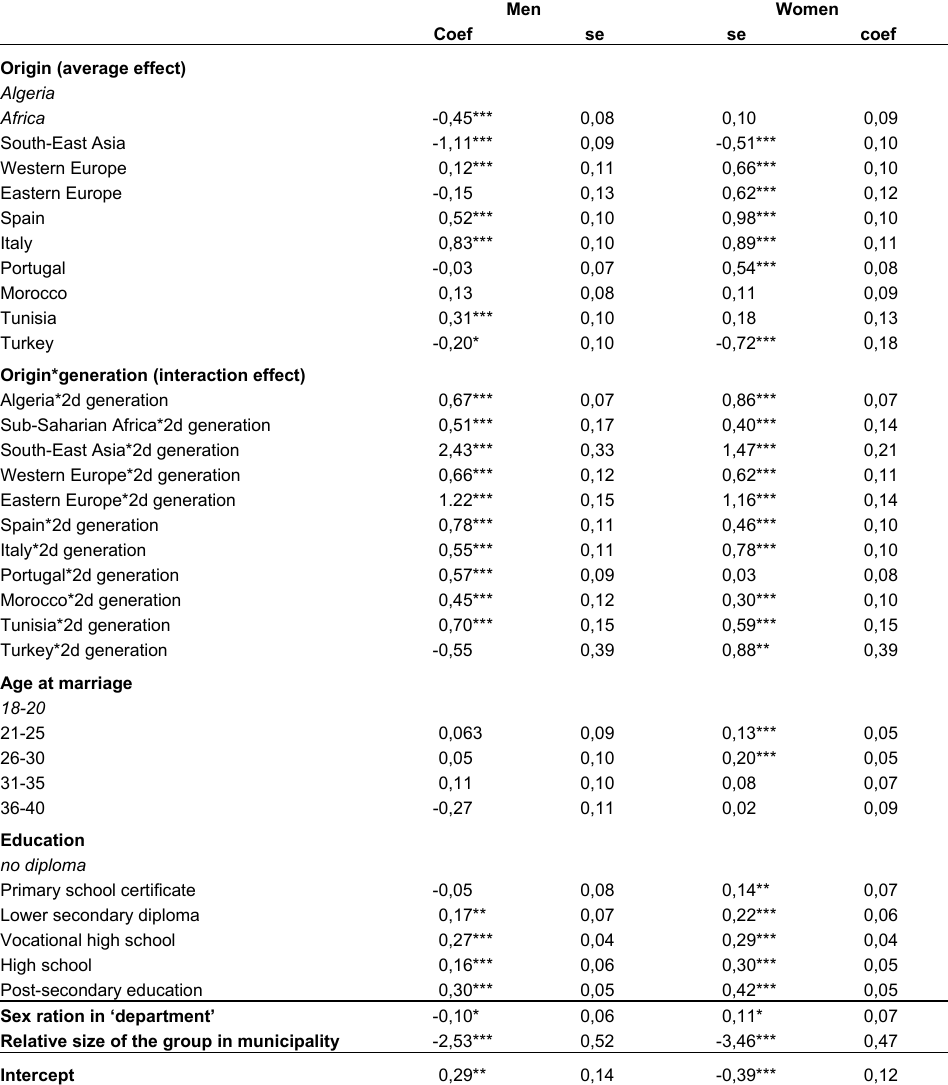
Table A.2: Probability of marriage with a French spouse born in France for first- and second-generation immigrants (probit model with interaction effects)